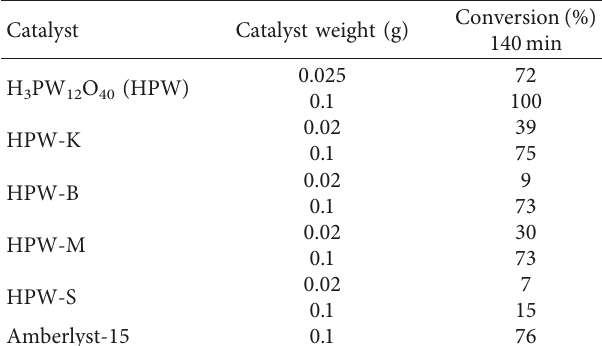
Figure 3: (a) Esterification of acetic acid with heptanol in the presence of HPW-K, HPW-M, and HPW-B using 0.02 g of catalysts. (b) Same esterification reactions carried out using 0.1 g of the catalyst. Notably, HPW-S showed extremely low catalytic activity when 0.02g of the catalyst was used. Table 2: Esterification of acetic acid with heptanol at 90 ° C using different amount of catalysts (0.02 and